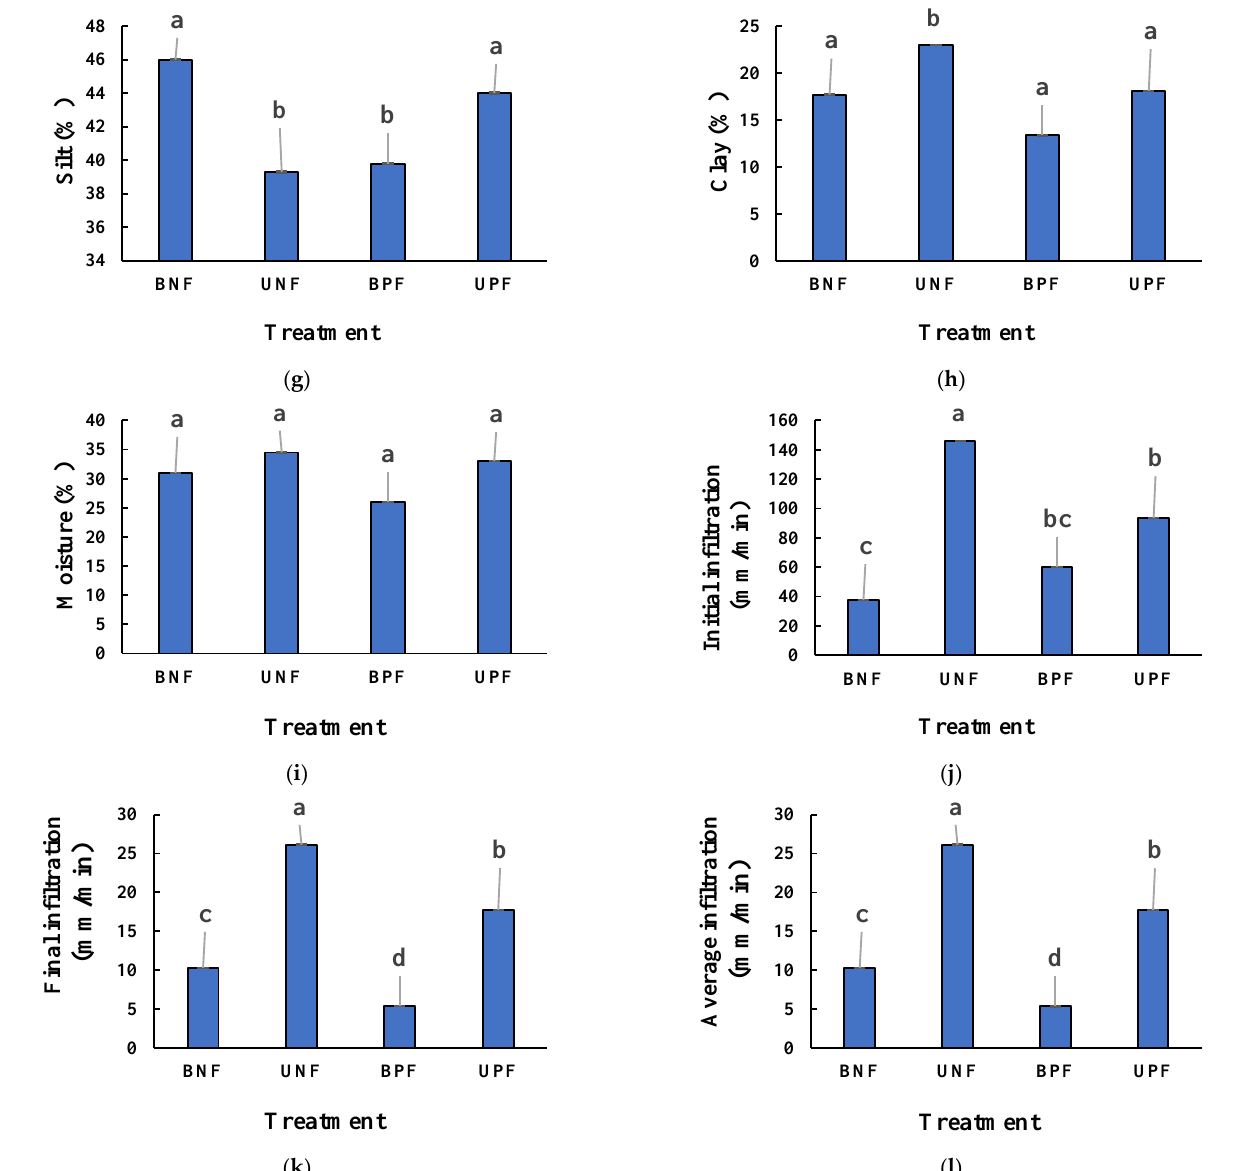
Figure 4. Comparison of the average soil physical properties under different plot types ( a – l ); BNF: Burned Natural Forest, UNF: Unburnt Natural Forest, BPF: Burned Plantation Forest, and UPF: Unburnt Plantation Forest.